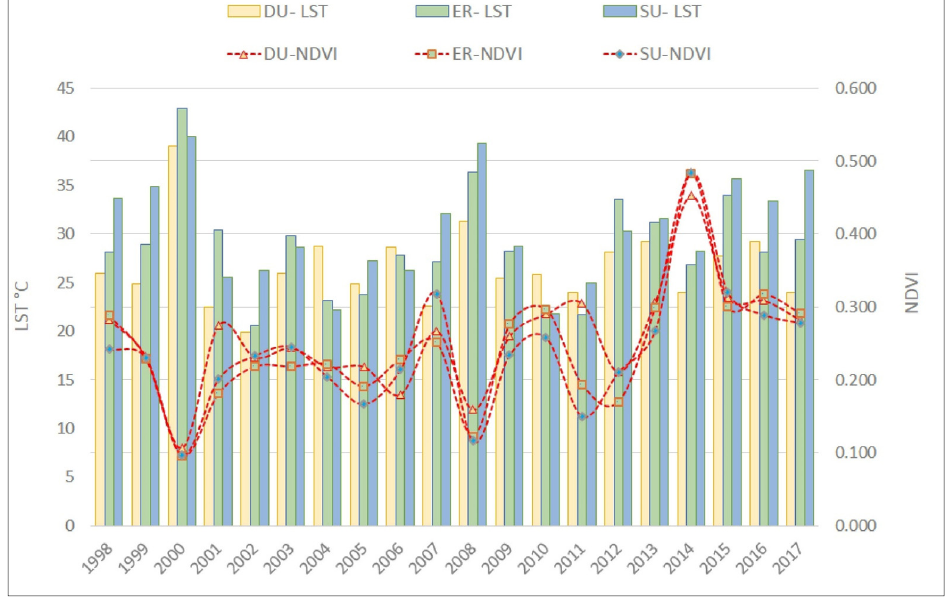
Figure 6. Average values of LST and NDVI in the ER, SU, and DU governorates (1998–2017).